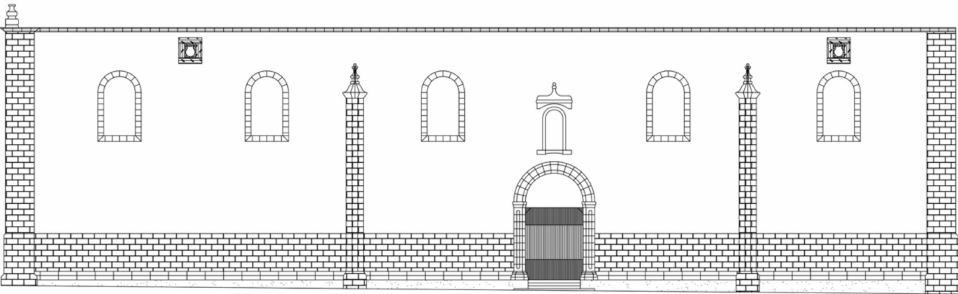
Figure 4. Scale drawings of the main and lateral façade obtained using photogrammetric restitution.